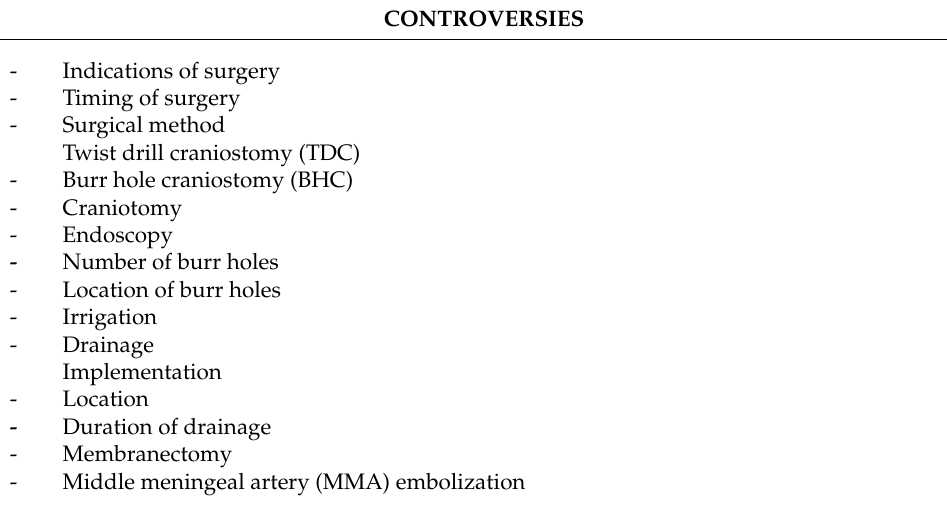
Table 1. Issues of controversy in the studies included in review.